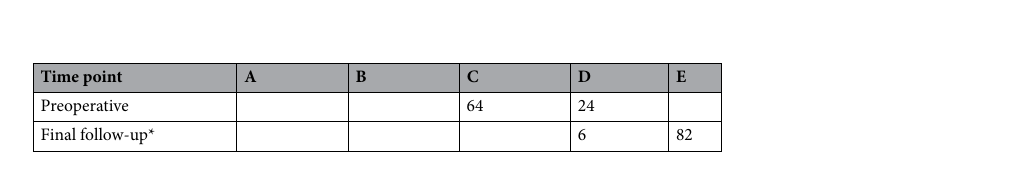
Table 2. Neurological recovery according to Frankel grade. * P < 0.05 versus